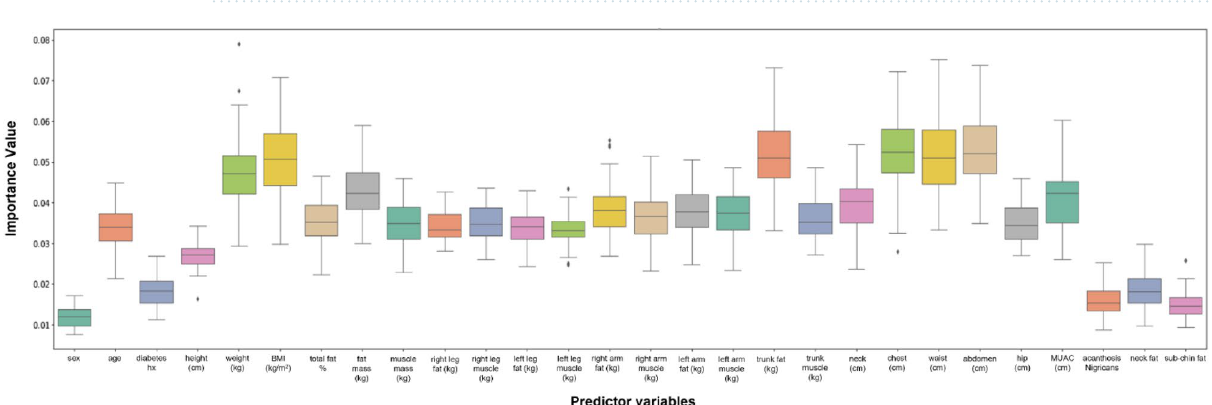
Figure 5. Box plots showing relative feature importance for stages of steatosis. hx history, cm centimeter, kg kilograms, BMI body mass index, MUAC mid-upper arm